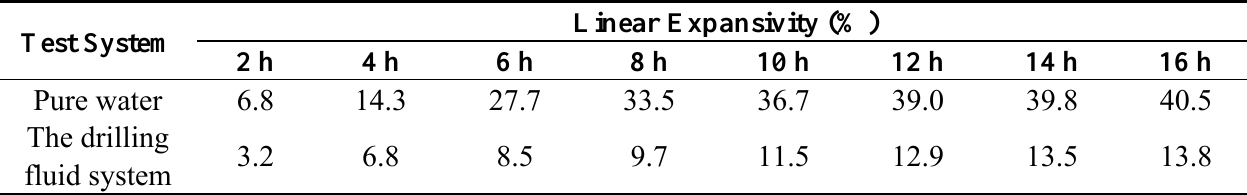
Table 1. The results of the shale expansion